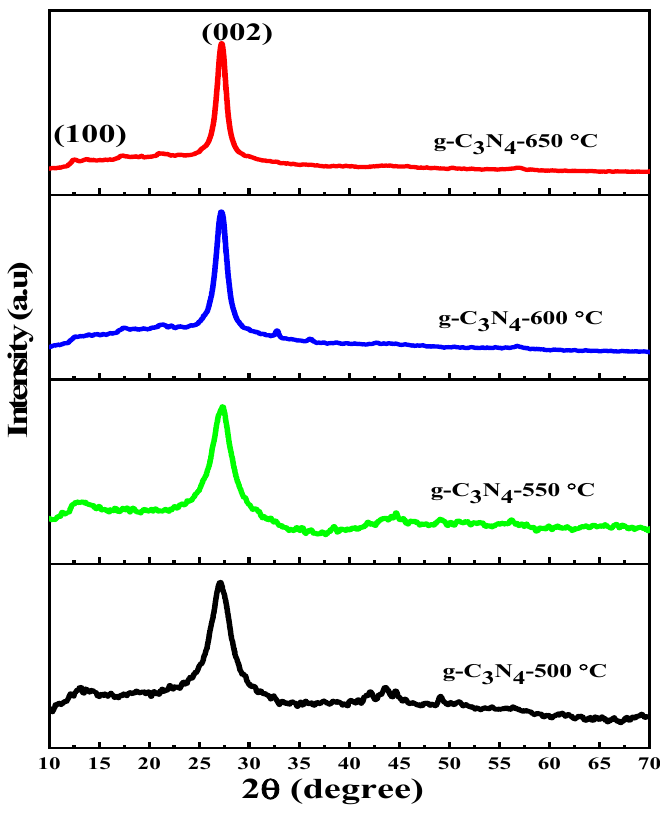
Figure 1. Calcination temperature-dependent XRD patterns of g-C 3 N 4 .